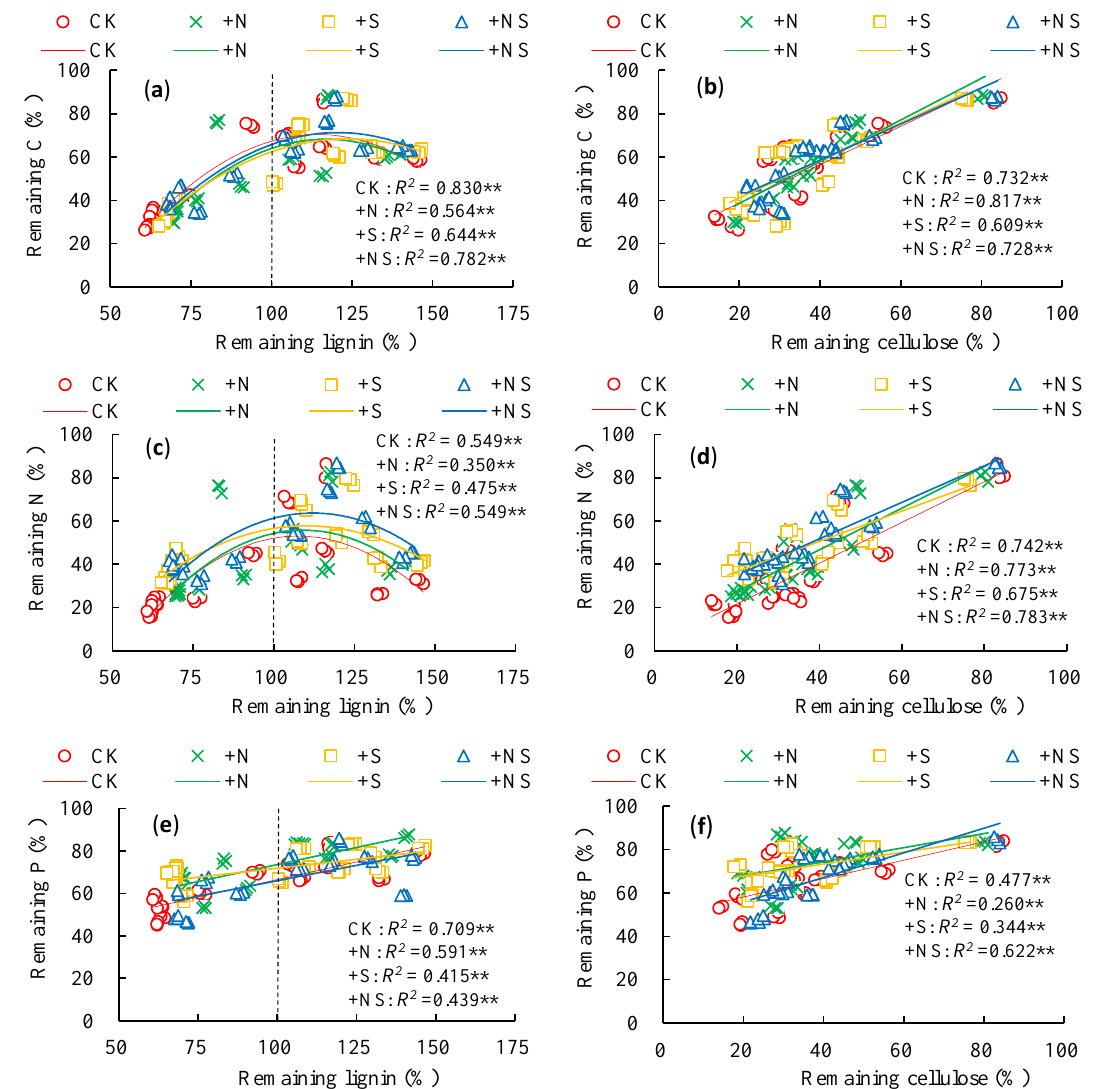
Figure 5. Correlations between remaining litter nutrients (% of the initial amount) and remaining (% of the initial amount) lignin and cellulose. ( a ), correlation between remaining litter C and remaining lignin; ( b ), correlation between remaining litter C and remaining cellulose; ( c ), correlation between remaining litter N and remaining lignin; ( d ), correlation between remaining litter N and remaining cellulose; ( e ), correlation between remaining litter P and remaining lignin; ( f ), correlation between remaining litter P and remaining cellulose. ** denotes that the coefficient of determination is highly significant ( p < 0.01). Data from each sampling time are aggregated. Treatment abbreviations are defined in Figure 2. n = 144.